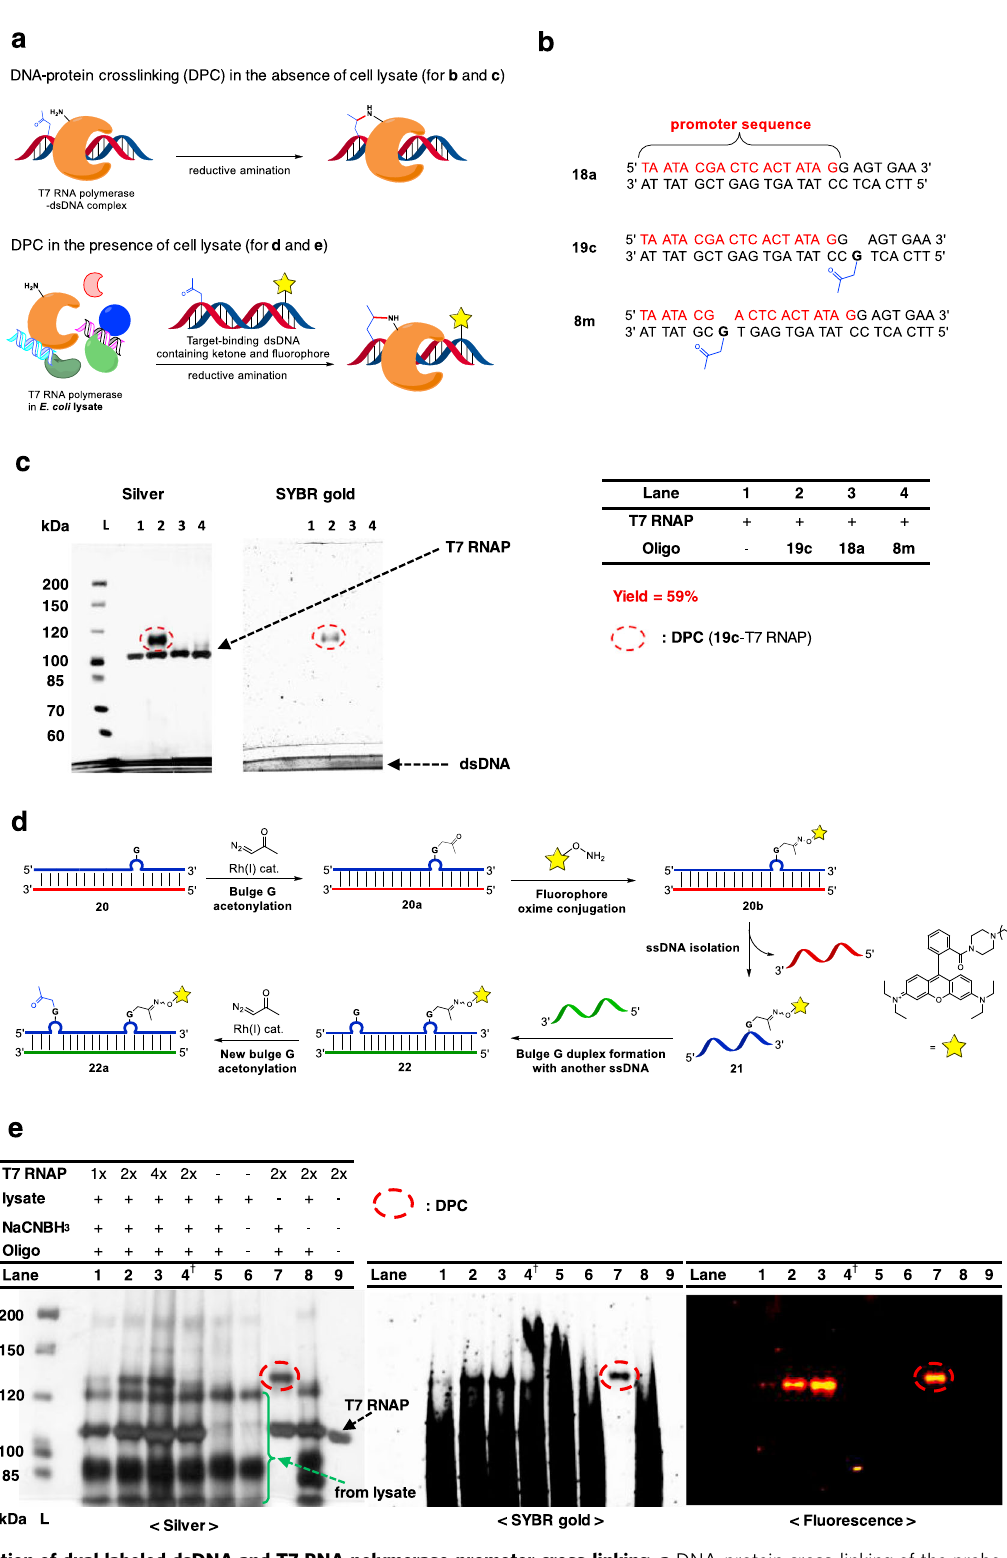
Fig. 7 Preparation of dual labeled dsDNA and T7 RNA polymerase-promoter cross-linking. a DNA-protein cross-linking of the probe and DNA-binding protein in the absence ( b and c ) and in the presence of E. coli lysate ( d and e ). b Oligonucleotide probes employed for c . c SDS – PAGE analysis of the cross- linking reaction visualized by silver and SYBR gold stains. Conditions: dsDNA (20 µ M), T7 RNA polymerase (T7 RNAP) (6.8 µ M), HEPES (40 mM), pH 7.4, Mg(OAc) 2 (5 mM), NaCNBH 3 (100 mM), 37 °C, 12 h. d Synthetic scheme for dual G-bulge probe 22a employed for e . e SDS – PAGE analysis of DNA- protein cross-linking in E. coli lysate. Conditions: dsDNA (20 µ M), T7 RNAP (3.4 µ M, for 1x), HEPES (40 mM), pH 7.4, Mg(OAc) 2 (5 mM), NaCNBH 3 (100 mM), 30% E. coli lysate, 37 °C, 12 h. † unmodi fi ed oligo was used. L: protein standard ladder. Source data are provided as a Source Data fi